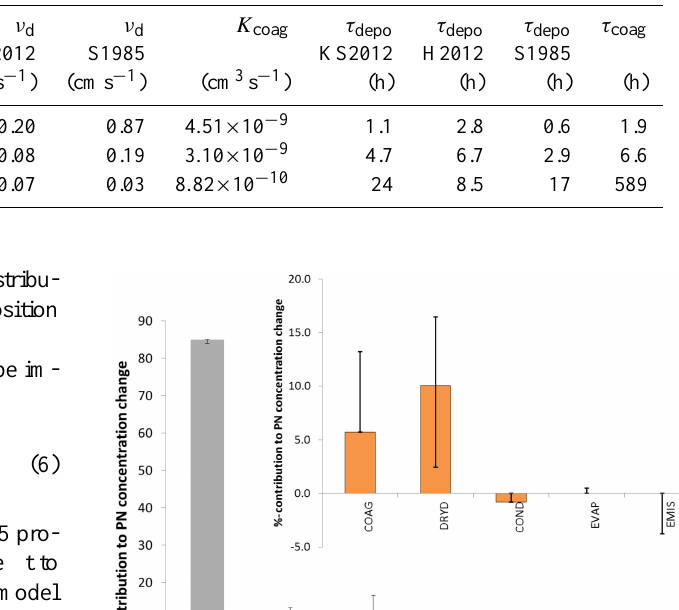
Table 5. Data required for the implementation of the PNC parameterization for dry deposition according to three different methodologies and for coagulation. Typical urban times scales for dry deposition ( τ depo ) and for coagulation ( τ coag ) is given as reference. MAFOR uses a large number of bin sizes so the extracted coefficients for the three size categories are based on an integral and/or average over a number of bins in the model. The initial size distribution ratio is the PN fraction in each PNC category for the “mean of traffic sites” distribution. Dry deposition velocity and timescale was calculated with three different methods: KS2012 (Kouznetsov and Sofiev, 2012), H2012 (Hussein et al., 2012), and S1985 (Schack Jr. et al., 1985).